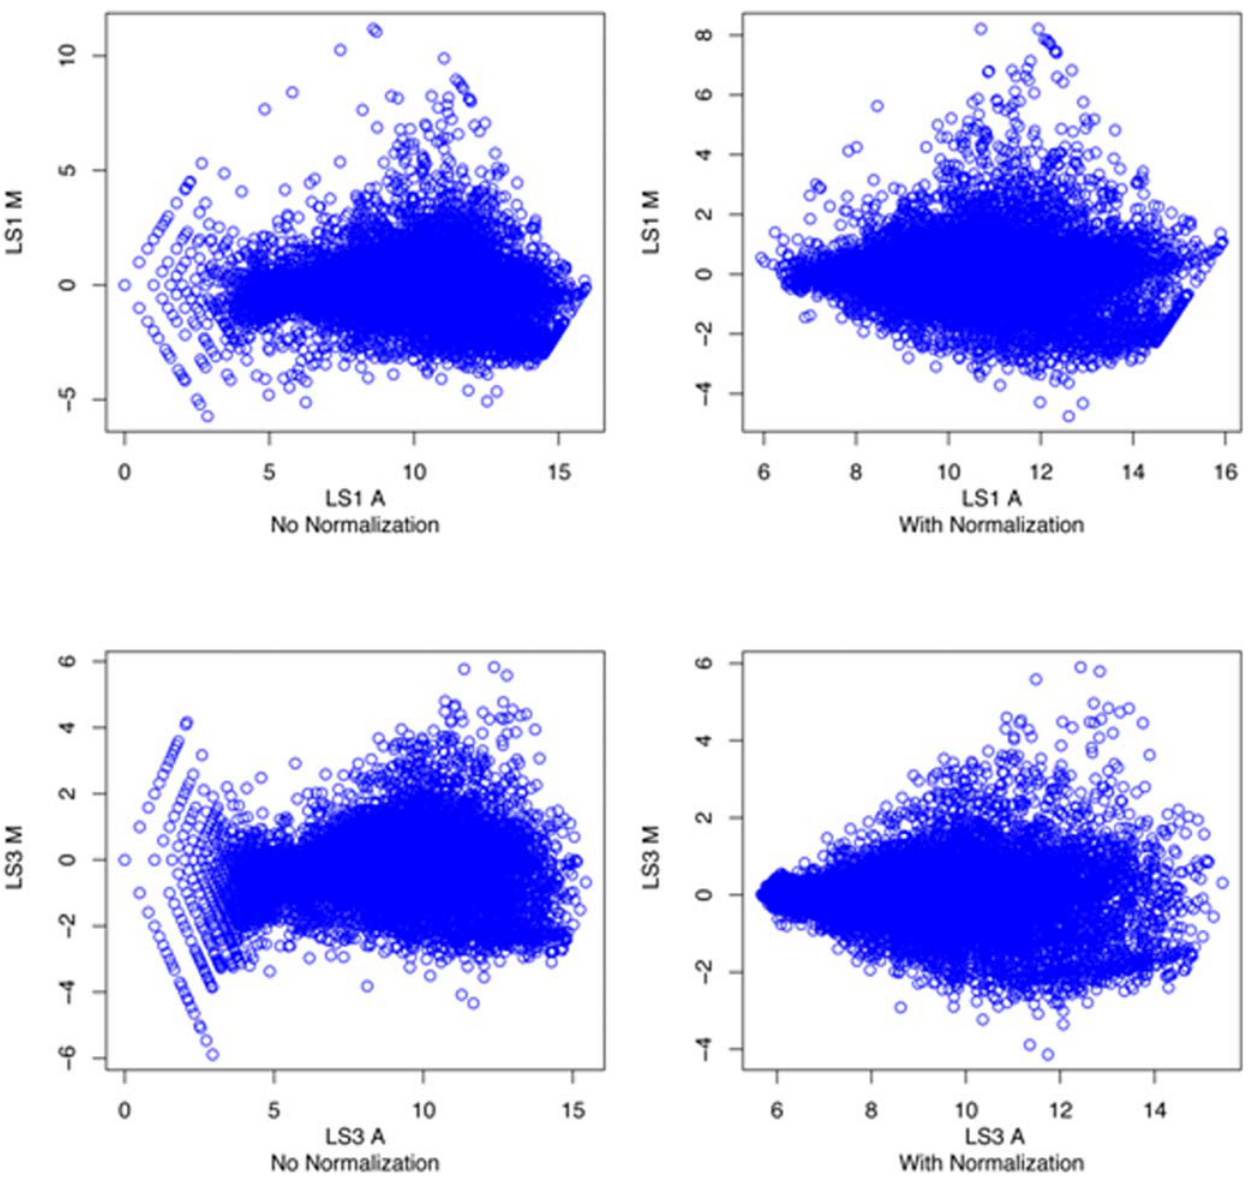
Figure 5. MA plots of microarray data from LS1 and LS3 tomato mutants before and after loess normalization.